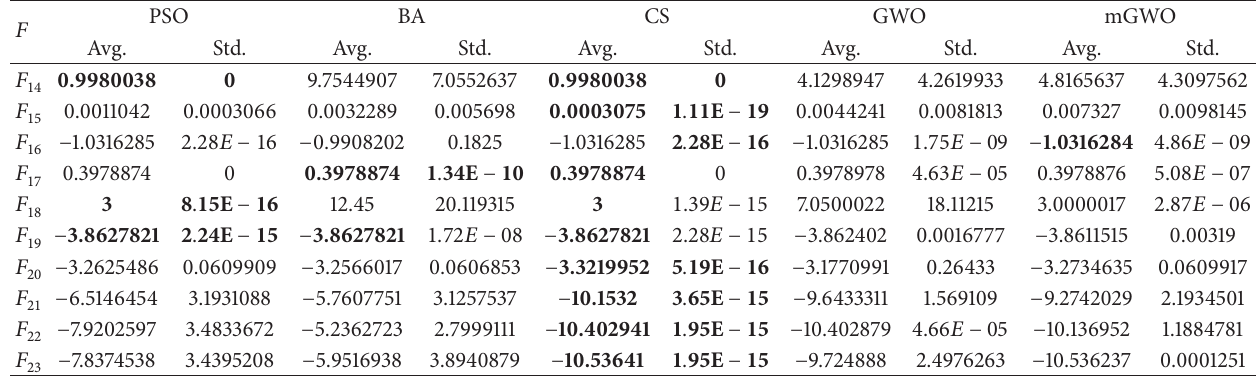
Table 7: Results of fixed-dimension multimodal